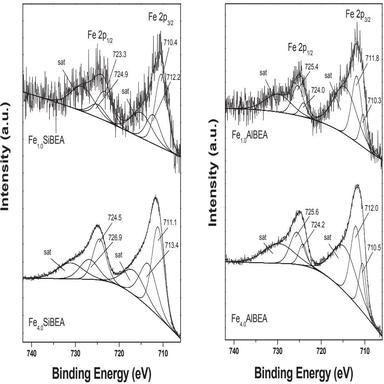
The XPS spectra of a) Fe 2p core excitation for FexSiBEA zeolites and b) Fe 2p core excitation for FexHAlBEA zeolites.